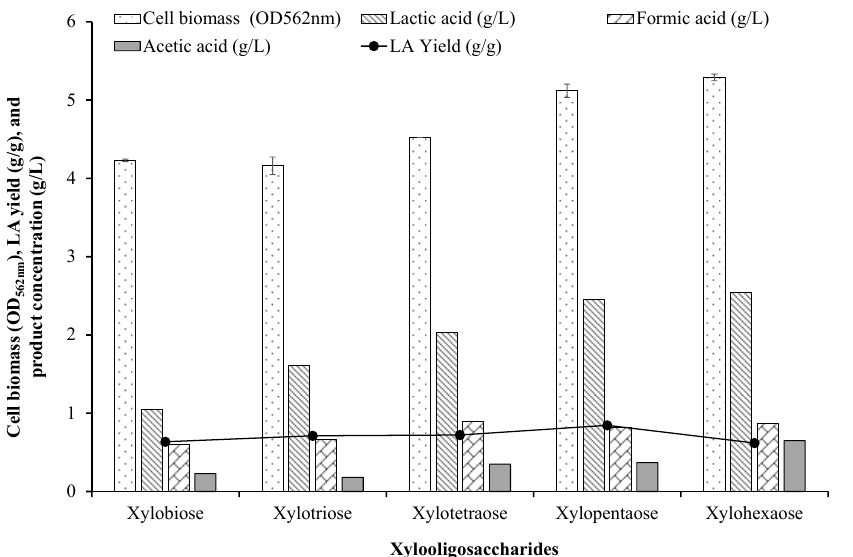
Figure 3. Lactic acid fermentation of xylobiose, xylotriose, xylotetraose, xylopentaose, and xylohex- aose by E. faecium s6 at initial pH 6.5 and 45 °C. Utilization of high XOS concentrations (50 g/L) was conducted under controlled pH fermentation conditions at 6.5 and 45 °C, as shown in Figure 4A. The strain grew rapidly and achieved a maximum biomass of OD 562 nm 13.1 after 12 h. Most XOS were consumed as indicated from HPLC profiles at zero time and after 144 h (Figure 5A,B). Strain E. fae- cium s6 metabolized 36.8 g/L of XOS homofermentateively within 144 h and produced 36.2 g/L of LA at a yield of 0.983 g/g -consumed sugar and productivity of 0.269 g/L.h. Few by-prod- ucts were produced of acetic acid (1.57 g/L), formic acid (1.31 g/L), and ethanol (1.37 g/L). The maximum LA productivity was 1.18 g/L.h. The low achieved cell biomass might be attributed to the lack of rapidly consumed monosugars (xylose) in the sugar mixture, as shown from HPLC analysis at zero time.